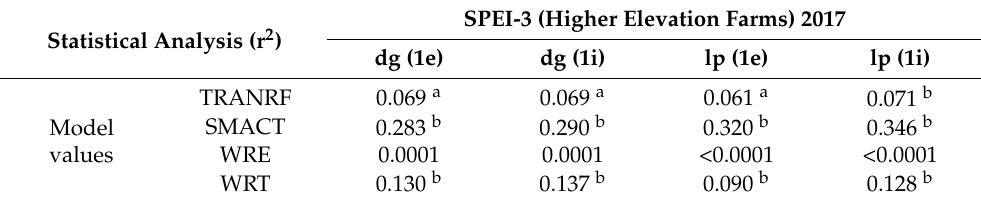
Table 3. Statistical analysis of drought index SPEI-3 at Farms1e and 1i and the LINGRA-N model results of yield (TRANRF, SMACT, WRE, WRT) for year 2017—shown are values of r 2 .